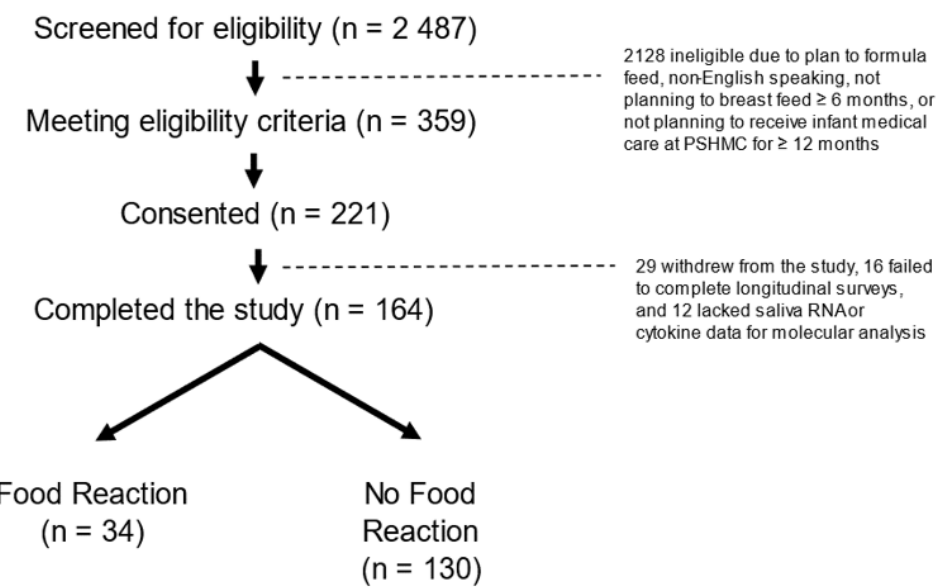
Figure 1. CONSORT Diagram: There were 2487 mother infant dyads screened, 359 eligible dyads approached, and 221 dyads consented. There were 164 infants for whom food allergy status could be confirmed in the first two years. There were 34 infants with food reactions (defined as parent reports of food sensitivity, intolerance, or allergy on the Infant Feeding Practice-II survey, and confirmed through a review of the medical record) and 130 infants without food reactions.